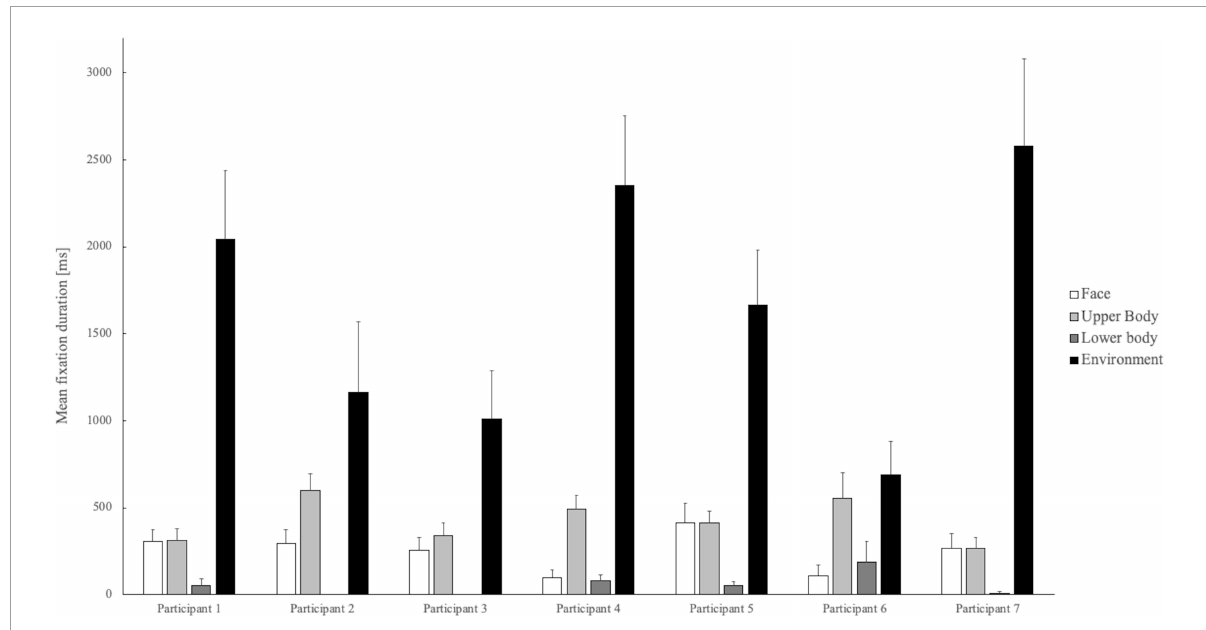
FIGURE1 Mean fixation time of the players on the different areas of interest in ms. The error bars indicate the respective standard errors.